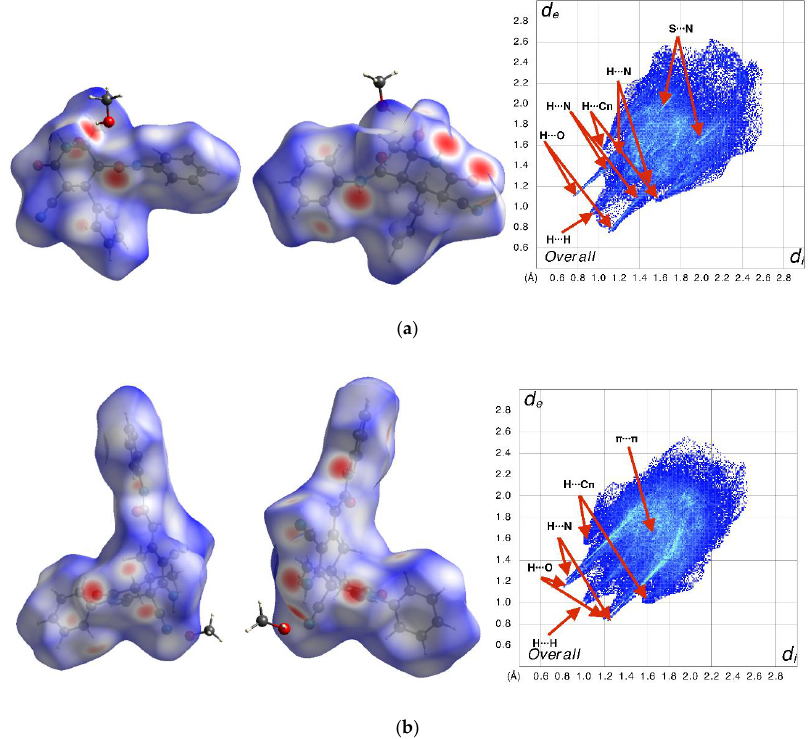
Figure 4. Hirshfeld surface analysis and fingerprint plot for compound 4 ( a ) and 9 ( b ).